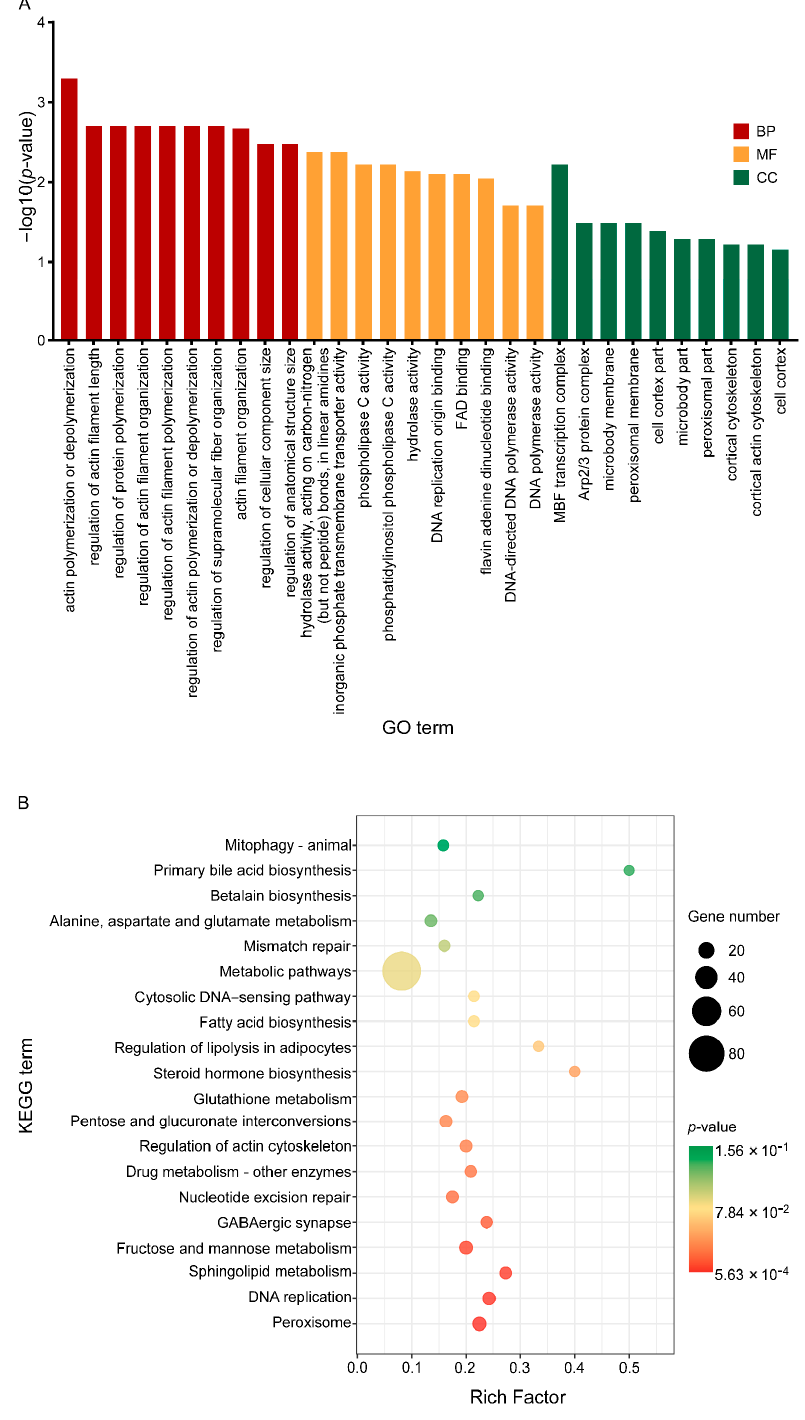
Figure 6. GO and KEGG enrichment map of the specific C17-mycosubtilin-responsible genes with C17 mycosubtilin treatment at 2 h. A. GO functional classification of the DEGs by p -value. The x-axis indicates different GO terms, and the y-axis indicates − log10 (corrected p -value) in each category. The top 10 enriched pathways of each category are shown in the figure. B. Scatter plot of enriched KEGG pathways. The rich factor is the ratio of the number of genes that were differentially expressed to the total number of genes in a certain pathway. The top 20 enriched pathways are shown in the